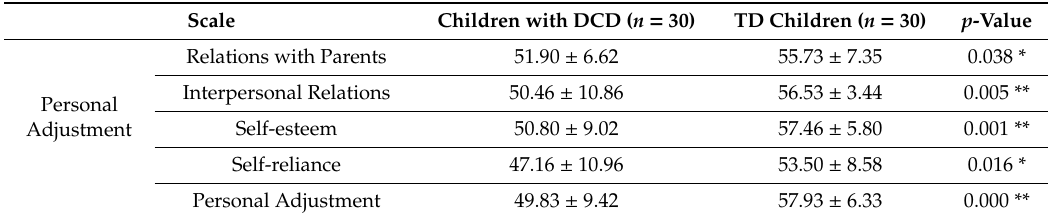
Table 4. Di ff erence between children with DCD and TD children’s behavioral problems.